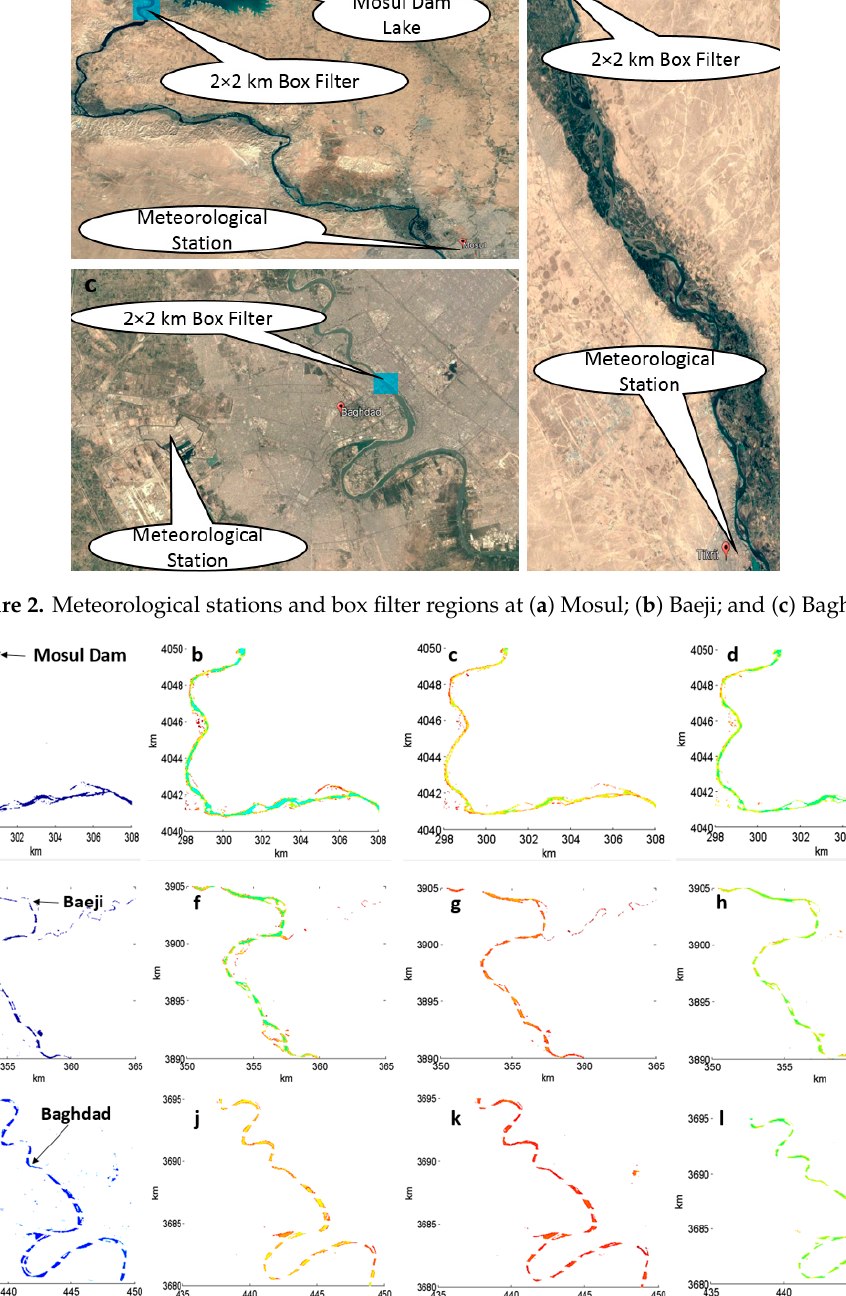
Figure 3. Seasonal variation in T w in 2009, estimated from Landsat satellite images for Mosul Dam on ( a ) 10 January; ( b ) 26 May; ( c ) 30 August; ( d ) 1 October for Baeji on ( e ) 4 February ; ( f ) 27 May; ( g ) 15 August; ( h ) 2 October and for Baghdad on ( i ) 4 February; ( j ) 27 May; ( k ) 15 August; ( l ) 2 October.